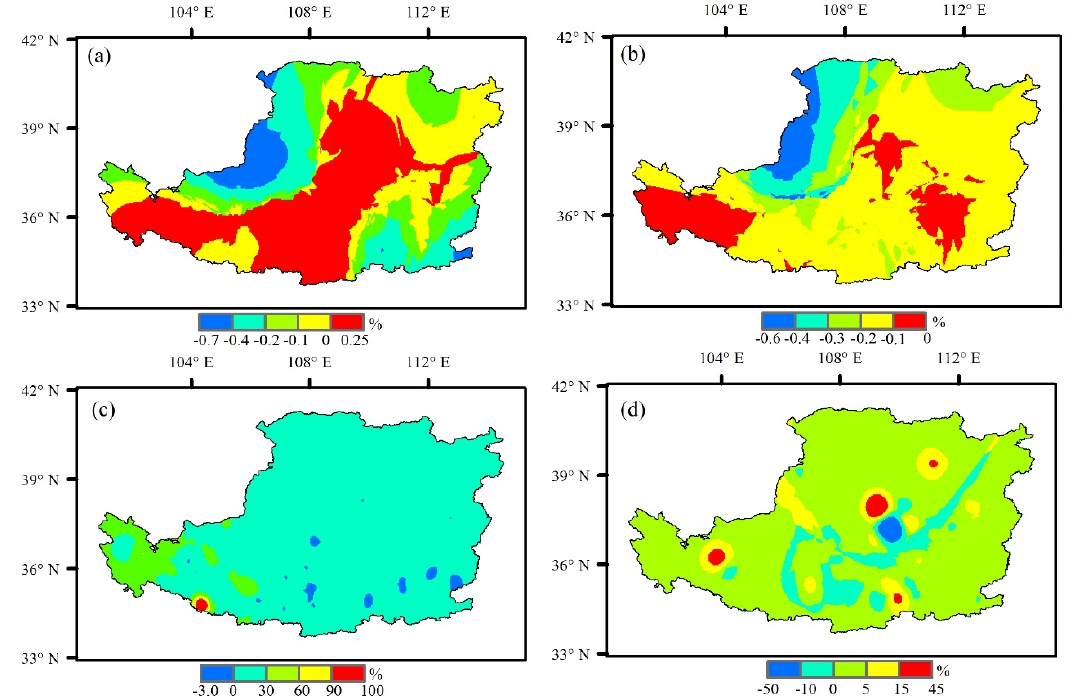
Figure 8. Incremental contribution distribution of different rainfall grades in rainfall intensity and frequency to rainfall amount (( a ) light rainfall, ( b ) moderate rainfall, ( c ) heavy rainfall and ( d ) rainstorm).